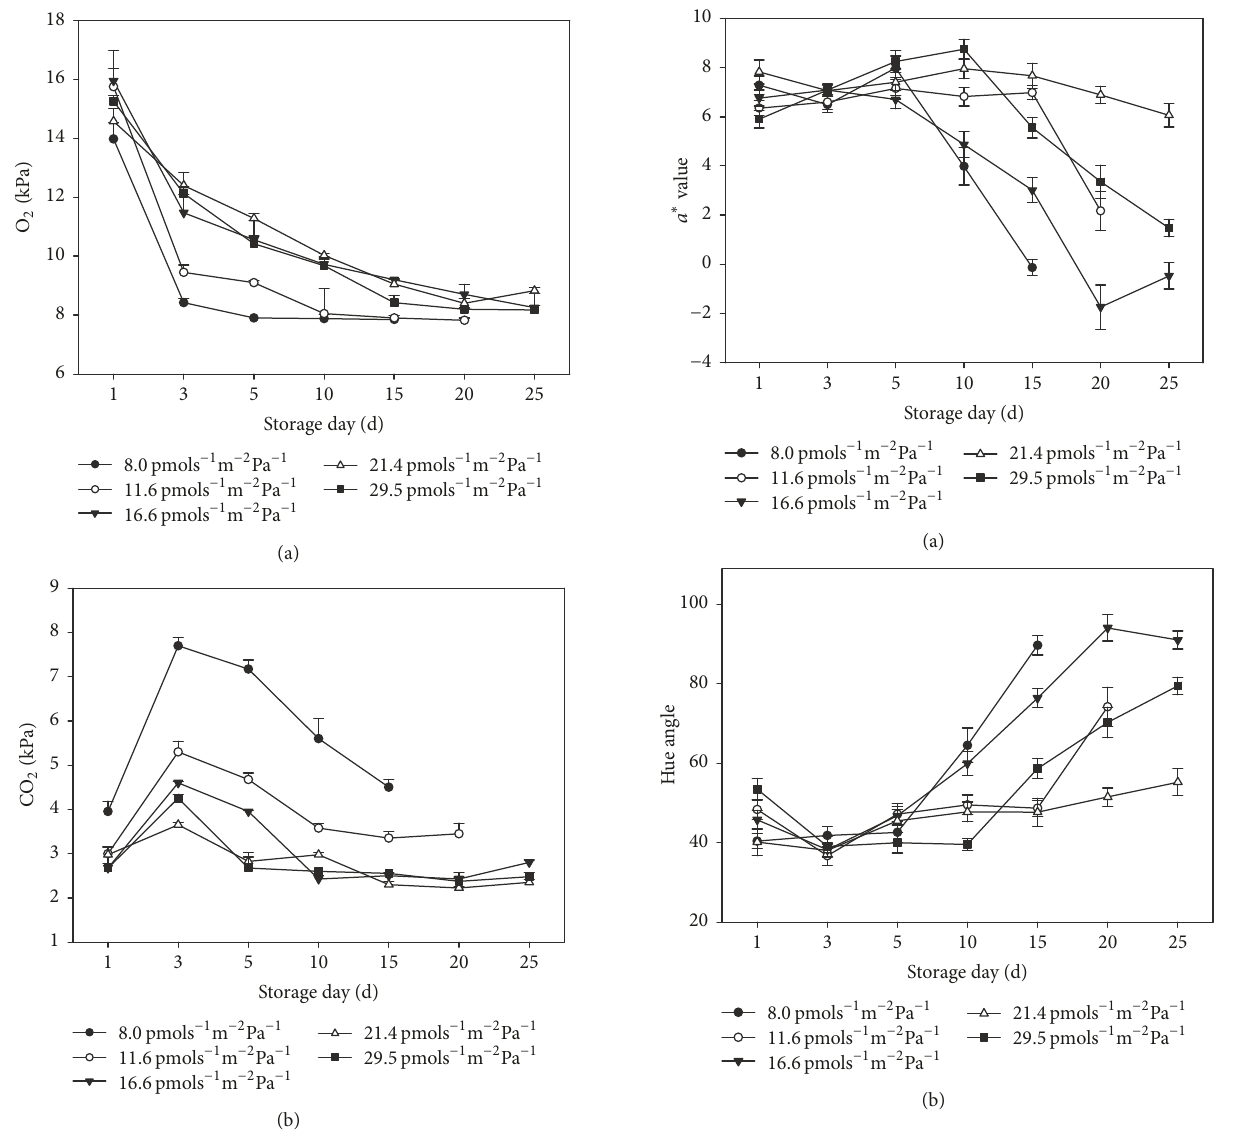
Figure 1: O 2 and CO 2 concentrations in package headspace as a function of storage time for Chinese toon tender shoots. Data points represent the mean ± SE ( 𝑛 = 4 ).